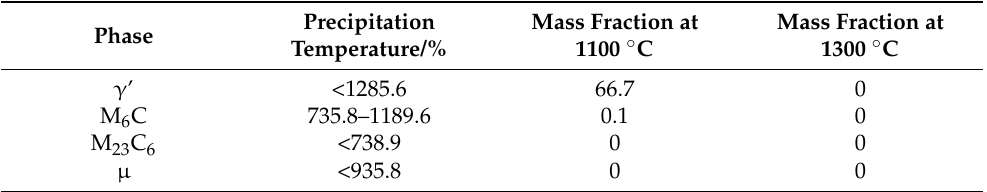
Table 2. Precipitation temperature range and mass fraction of the secondary phases in the experimen- tal superalloy between 700 ◦ C and 1400 ◦ C based on Pandat software.